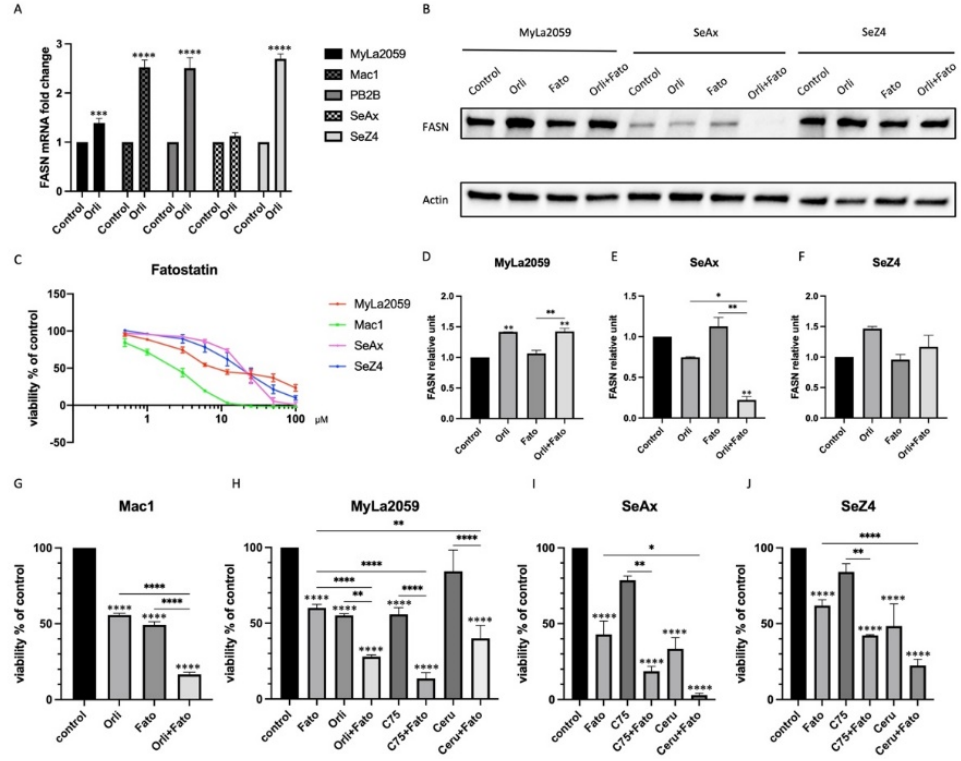
Figure 3. Inhibition of SREBP could prevent the upregulation of FASN induced by Orlistat or cause further inhibition on FASN, enhancing the potency of Orlistat on cell viability. ( A ) Orlistat caused the increase of FASN mRNA and ( B ) FASN protein, except in SeAx cells. Inhibition of SREBP by Fatostatin partially counteracted this upregulation in SeZ4, while it enhanced the inhibition of Orlistat on FASN in SeAx cells. ( D – F ) Quantification of protein level in western blot. ( C ) Fatostatin also impaired the cell viability in CTCL cell lines, but ( G ) when combined with the FASN inhibitor, it could incur more suppression compared to each of these inhibitors alone. Unless otherwise stated, the concentration of Cerulenin, C75, and Fatostatin used in this study was, respectively, 6 μ M, 75 μ M, and 5 μ M in Mac1 and MyLa2059 and 10 μ M, 150 μ M, and 20 μ M in SeAx and SeZ4. The concentration of Orlistat used in SeAx and SeZ4 was 75 μ M, while in Mac1 and MyLa2059 it was 1 μ M for qPCR and MTT assay, and 10 μ M for western blot. Western blot and MTT assay were per- formed after 48 h of stimulation, and qPCR was performed after 24 h. Statical significance between the control and individual samples were tested with two-sided Student’s t test for graph A. One- way ANOVA (Tukey’s) test was used for graph ( D – J ) as described in materials and methods. As- terisks above each column in ( A , D – J ) indicate the significance of difference compared to the control, while bars with asterisks show the statistical significance between one inhibitor alone and two in- hibitors in combination (* p ≤ 0.05; ** p ≤ 0.01; *** p ≤ 0.001, **** p ≤ 0.0001). This in turn triggered the upregulation of SREBP and subsequent FASN as a feedback loop to compensate the lipid needs in the cells. Therefore, to verify whether additional inhibition of SREBP could incur further inhibition of FASN or prevent the upregulation of FASN induced by FASN inhibitors, we introduced Fatostatin, an SREBP inhibitor, that represses the activation of SREBP by interfering with the ER-to-Golgi transport of SCAP, and thereby theoretically blunts the feedback loop between FASN expression and cellular lipid level [42]. Quantification of western blot in Figure 3D–F confirmed this hypothesis. Although no obvious changes could be seen in MyLa2059 cells, the combination of Fatostatin and Orlistat led to more reduction of FASN in SeAx cells and partially counteracted the